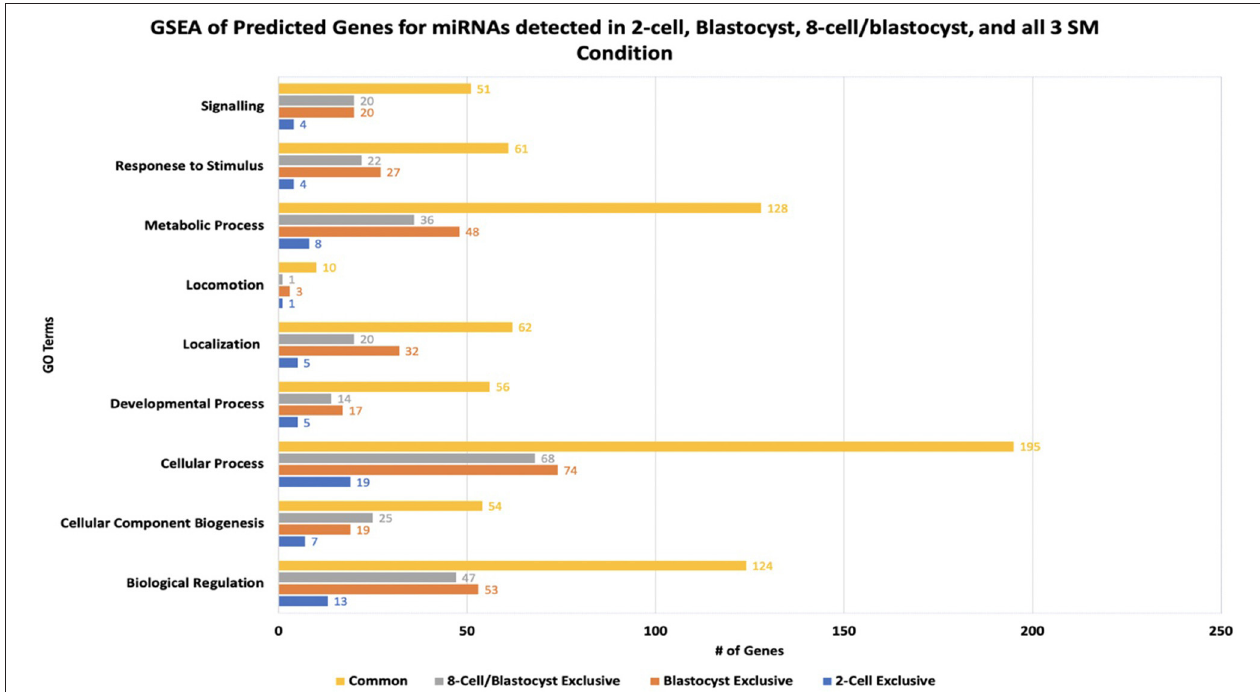
FIGURE 7 | Results of gene-set enrichment analysis of mRNA targets predicted for differentially expressed miRNAs in 2-cell spent media, blastocyst spent media, shared in 8-cell and blastocyst spent media, and common to all 3 spent media conditions. The majority of predicted genes clustered under biological processes involved in cellular process, biological regulation, and metabolic